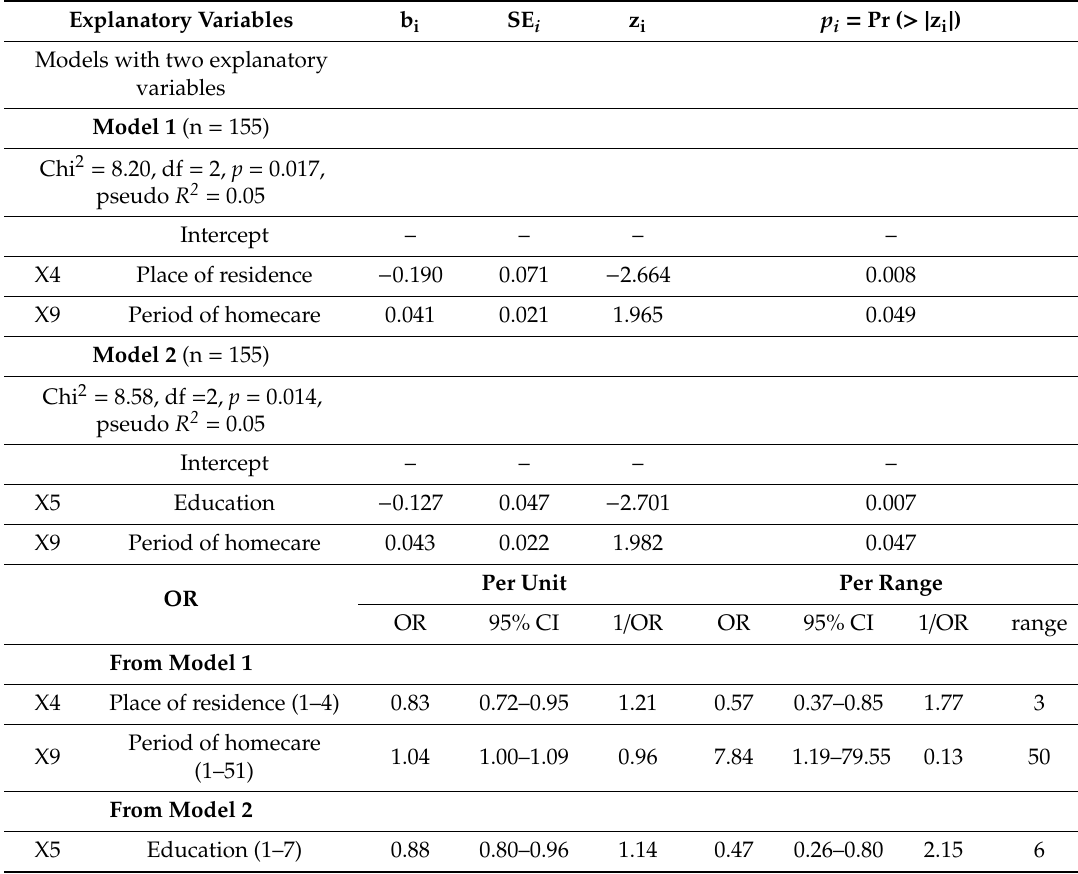
Table 8. Results of logistic regression analysis and the odds ratio in logistic regression model in caregivers. Explained variable: Depersonalization (0—smaller, 1—bigger